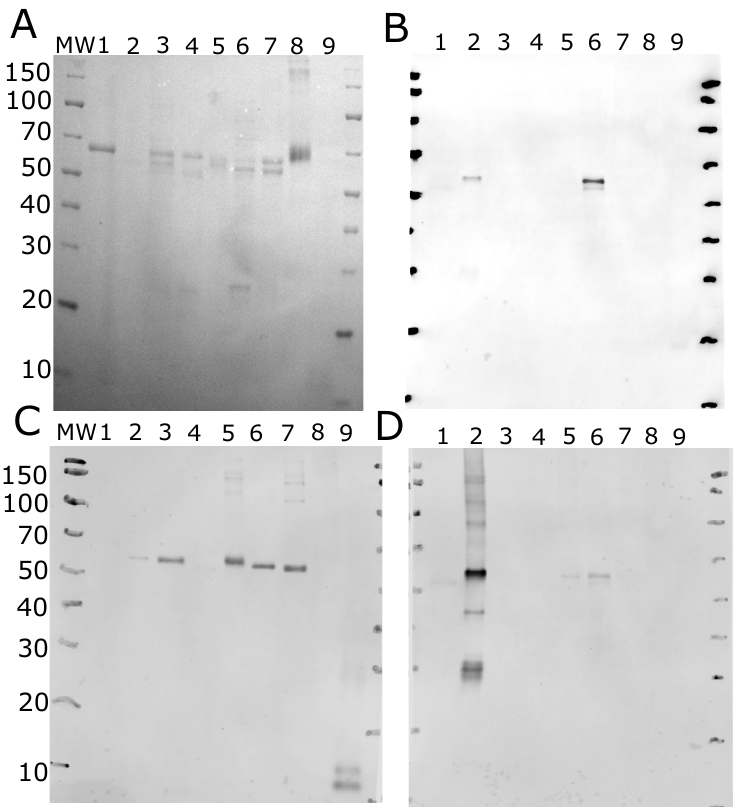
Figure A1. Western blot analysis for antigens. Lanes 1-7 are VP1 proteins for CVA4, CVB1, PV1 EV-D68, RV-A89, RV-B14, RV-C3, lane 8 is BSA, and lane 9 is 2A. Panel ( A) shows the Ponceau-staining of the nitrocellulose membrane after transfer, ( B ) 3A6 anti-CVB1 monoclonal antibody, ( C ) anti-his antibody and ( D ) Dako 5D8 /